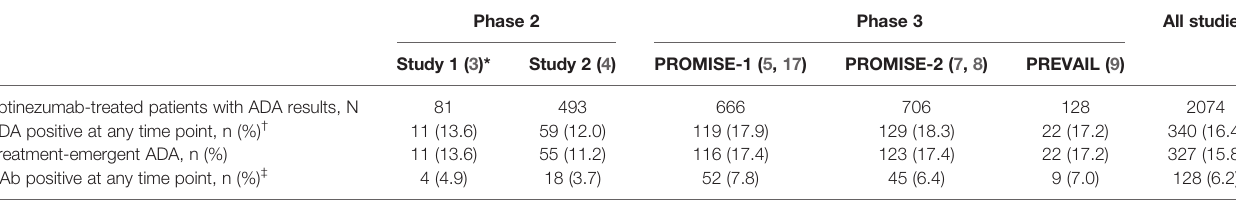
TABLE 2 | Incidence of ADA/NAb by study (safety